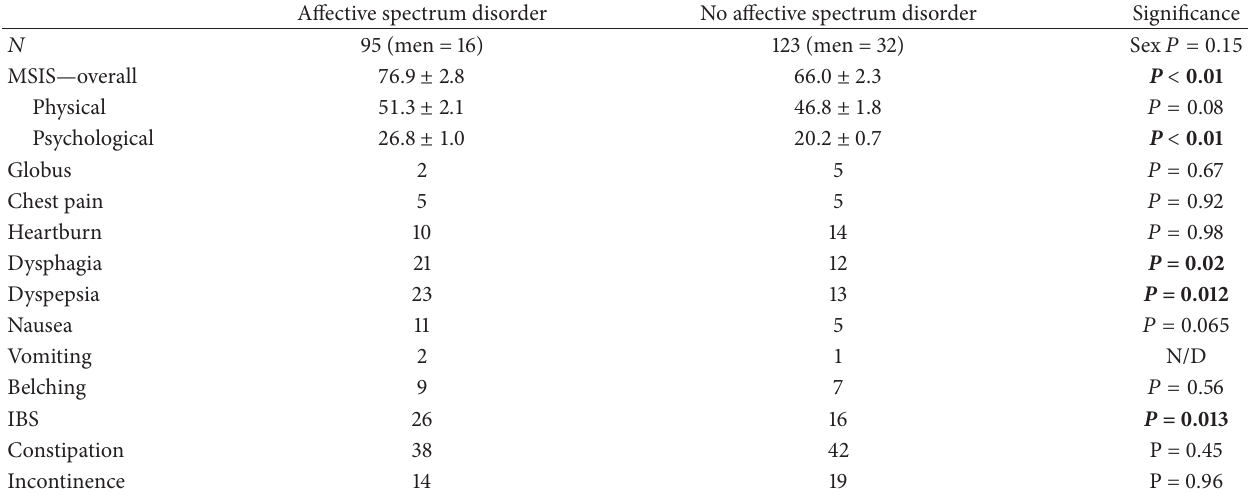
Table 3: Impact of reported affective spectrum disorder on MSIS score, gastrointestinal symptoms, and gastrointestinal